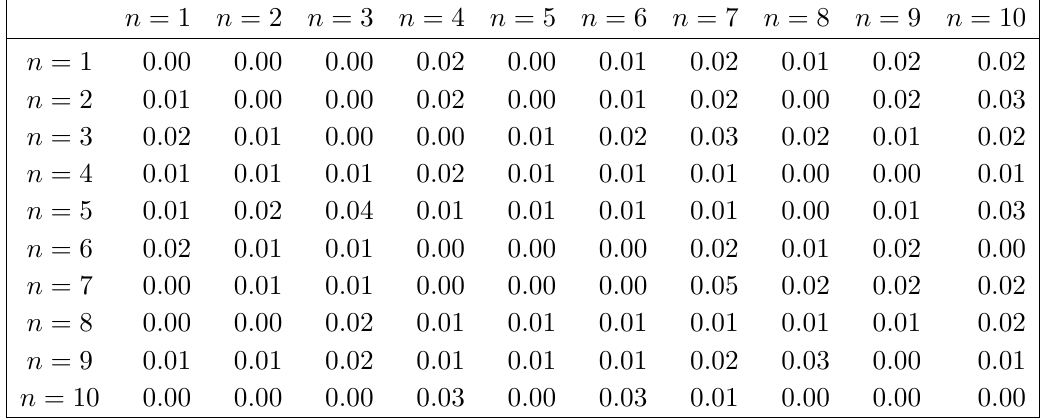
Magnitude of overlap between 0 ++ (rows) and 8 ++ (columns) eigenstates (at time separation 4 lattice units; before projection out of overlaps between 0 ++ (rows) and 8 ++